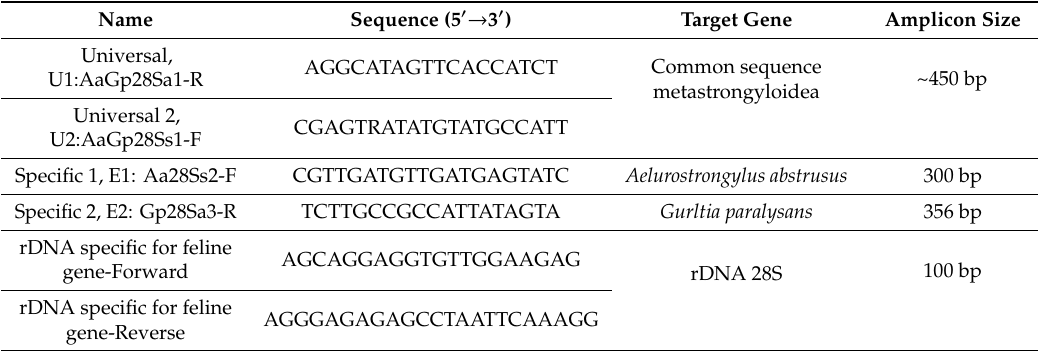
Table 1. Universal and species-specific primer set for the detection of Gurltia paralysans and Aelurostrongylus abstrusus